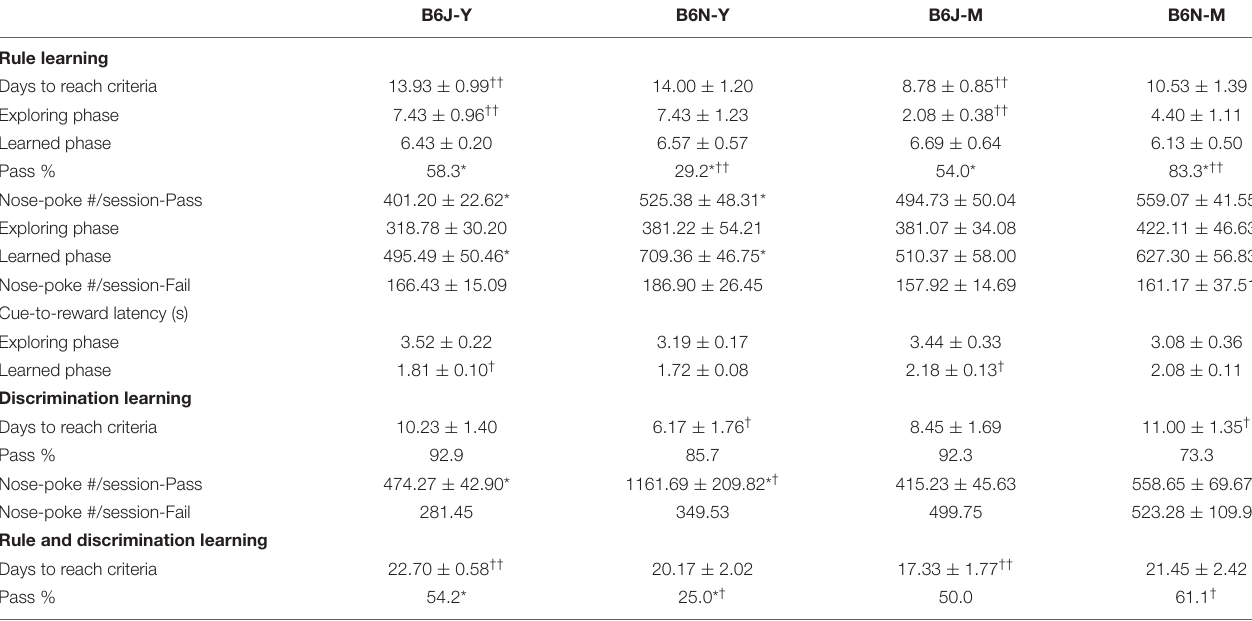
TABLE 1 | Parameters of four animal groups measured in different training stages and results of statistical